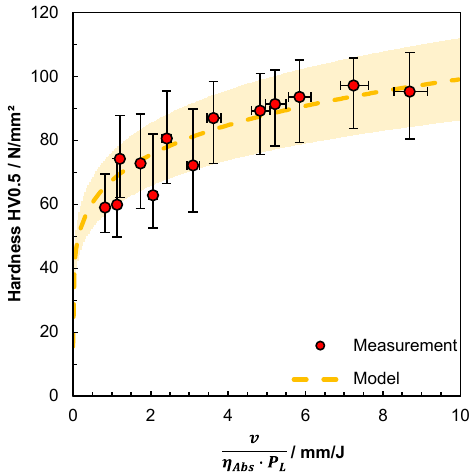
Figure 6. Hardness in HV0.5 as a function of the process parameters. The yellow dashed line corresponds to the proposed model given by Equation (10). The uncertainty due to the variable material properties is represented by the light orange shaded area. The points show the experimentally measured hardness averaged over 90 measurements in the three sections. The height of the vertical error bars shows the minimum and maximum values of the standard deviation, which are shown in Figure 5. The error bars in x -direction show the possible variation of the absorptance η Abs ± 5% as shown in Table